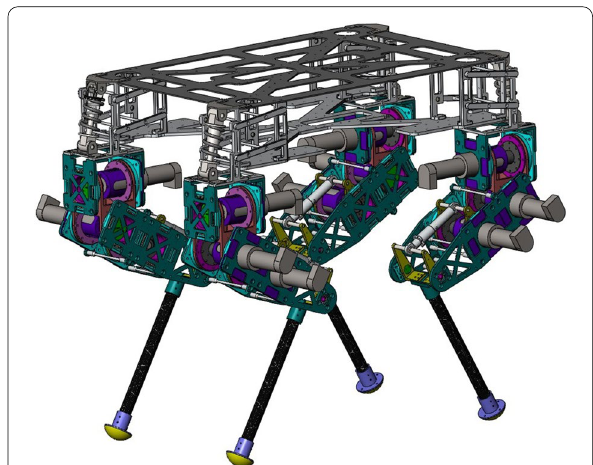
Figure 24 Virtual prototype of the quadruped robot